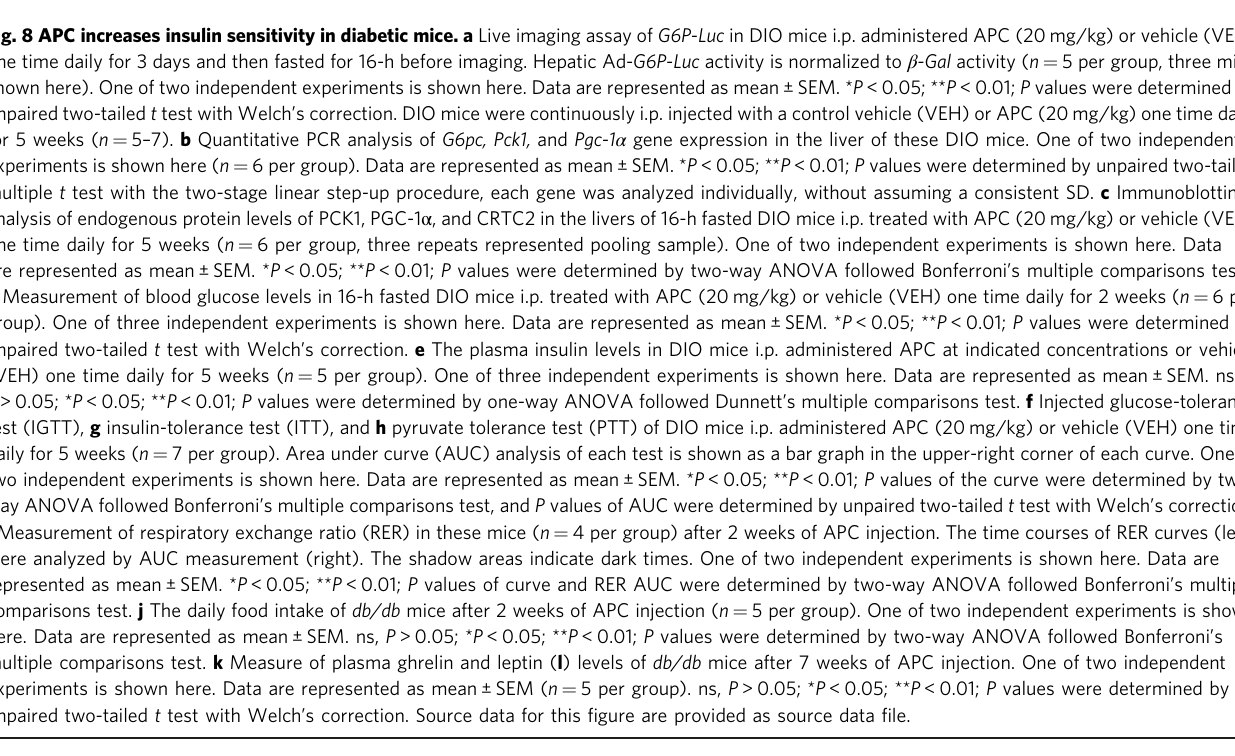
Fig. 8 APC increases insulin sensitivity in diabetic mice. a Live imaging assay of G6P - Luc in DIO mice i.p. administered APC (20 mg/kg) or vehicle (VEH) one time daily for 3 days and then fasted for 16-h before imaging. Hepatic Ad- G6P - Luc activity is normalized to β -Gal activity ( n = 5 per group, three mice shown here). One of two independent experiments is shown here. Data are represented as mean ± SEM. * P < 0.05; ** P < 0.01; P values were determined by unpaired two-tailed t test with Welch ’ s correction. DIO mice were continuously i.p. injected with a control vehicle (VEH) or APC (20 mg/kg) one time daily for 5 weeks ( n = 5 – 7). b Quantitative PCR analysis of G6pc, Pck1, and Pgc-1 α gene expression in the liver of these DIO mice. One of two independent experiments is shown here ( n = 6 per group). Data are represented as mean ± SEM. * P < 0.05; ** P < 0.01; P values were determined by unpaired two-tailed multiple t test with the two-stage linear step-up procedure, each gene was analyzed individually, without assuming a consistent SD. c Immunoblotting analysis of endogenous protein levels of PCK1, PGC-1 α , and CRTC2 in the livers of 16-h fasted DIO mice i.p. treated with APC (20 mg/kg) or vehicle (VEH) one time daily for 5 weeks ( n = 6 per group, three repeats represented pooling sample). One of two independent experiments is shown here. Data are represented as mean ± SEM. * P < 0.05; ** P < 0.01; P values were determined by two-way ANOVA followed Bonferroni ’ s multiple comparisons test. d Measurement of blood glucose levels in 16-h fasted DIO mice i.p. treated with APC (20 mg/kg) or vehicle (VEH) one time daily for 2 weeks ( n = 6